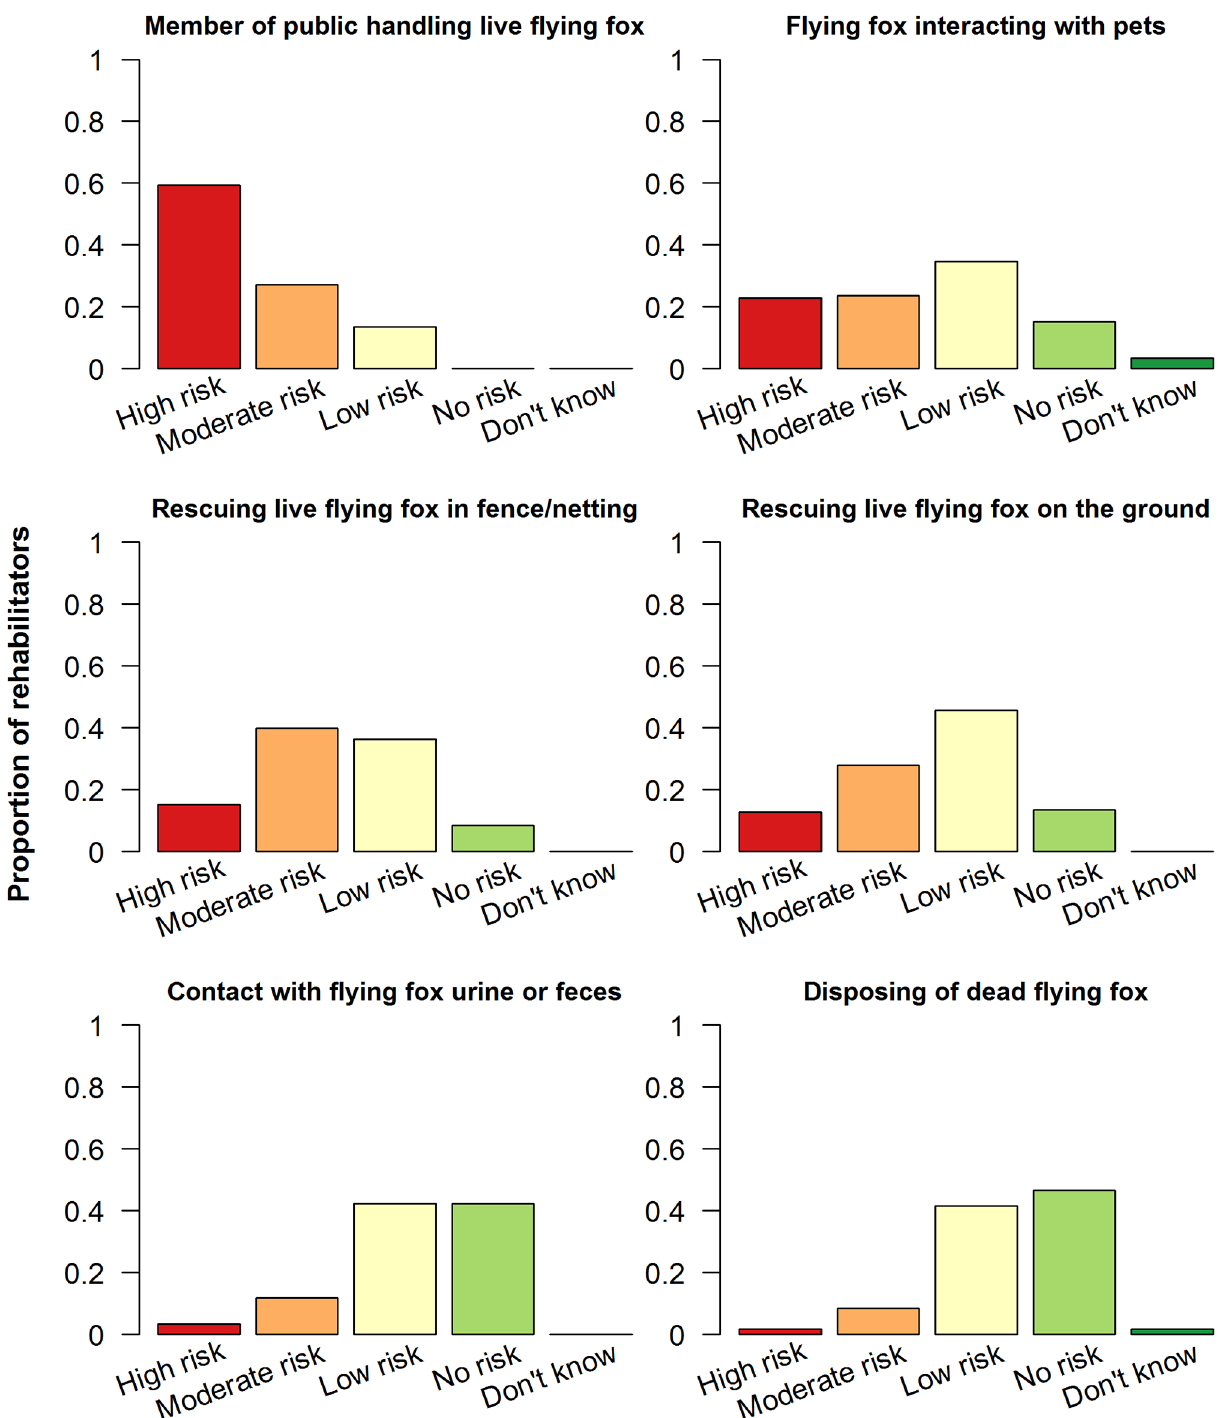
Fig 1. Risk to human health rated by 118 Australian flying fox rehabilitators, 2014. Rehabilitators assigned risk ratings to multiple hypothetical scenarios involving a flying fox.